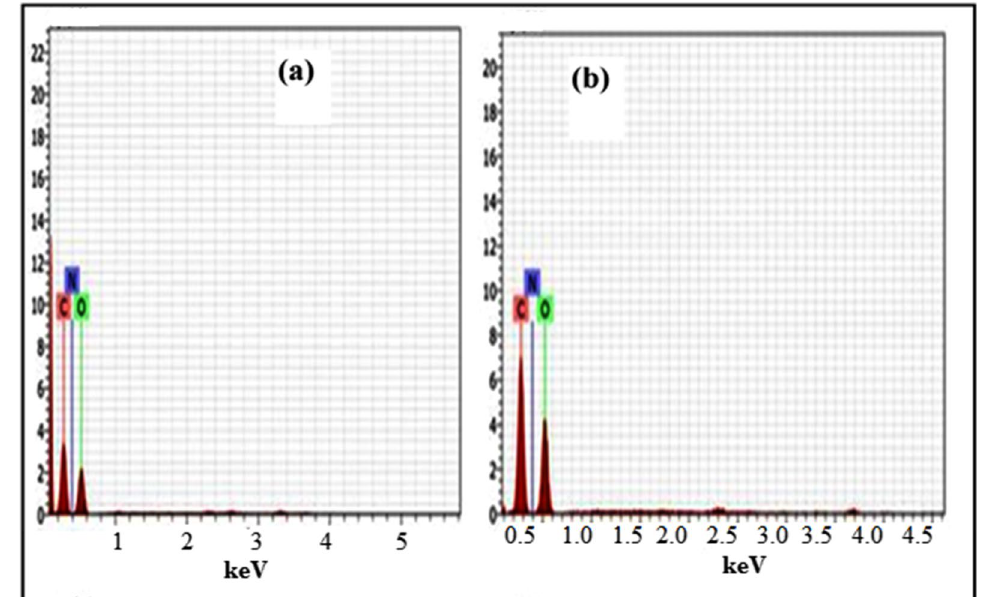
Fig. 4 a, b: EDS of a aloe vera and b